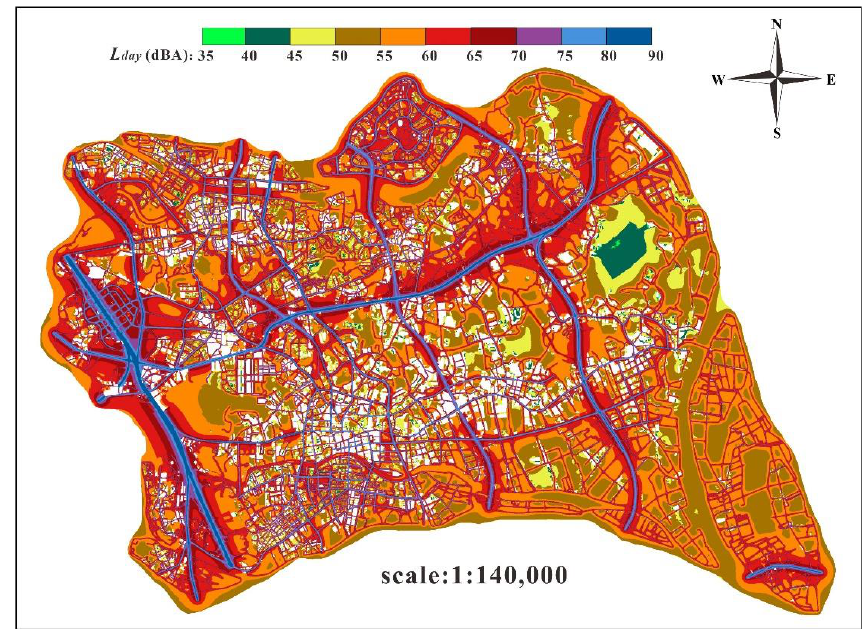
Figure A1. Daytime urban traffic noise map of Panyu District, Guangzhou City [36].